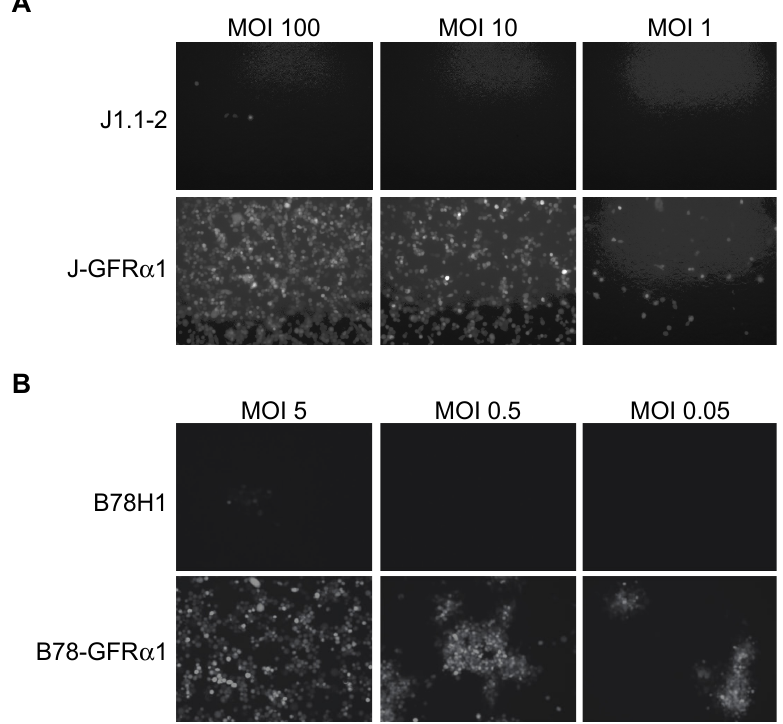
Figure 2. Receptor dependence of KNTc-gD:GDNF virus entry. Infection of ( A ) J1.1–2 and J-GFR α 1 cells or ( B ) B78H1 and B78-GFR α 1 cells with KNTc-gD:GDNF virus at the indicated multiplicities of infection (MOIs) based on pfu (plaque-forming unit) titers on GFR α 1-transduced U2OS cells (U2OS-ICP4-GFR α 1, Figure S1) (Table 1). Virus entry into cells was visualized at 24 h post infection (hpi) as mCherry fluorescence.